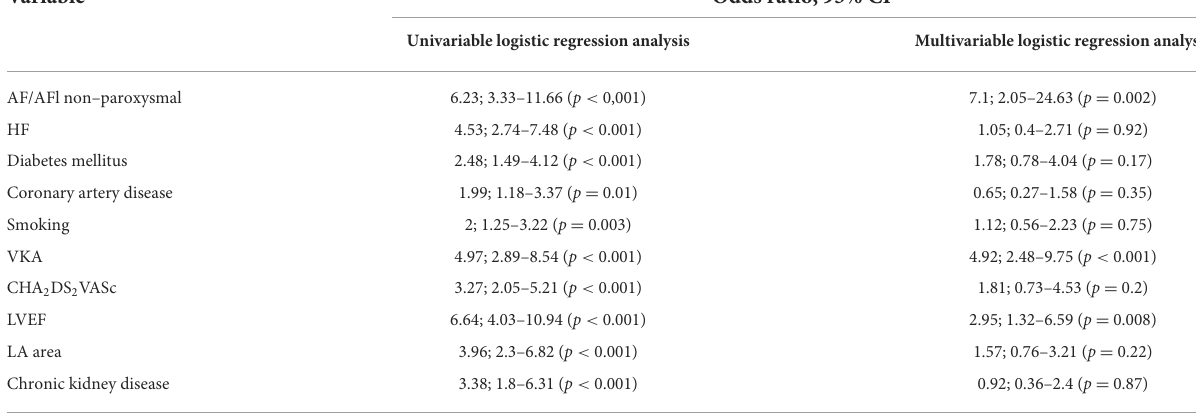
TABLE 3 Results of univariable and multivariable logistic regression analysis – predictors of left atrial thrombus. Variable Odds ratio; 95% CI Univariablelogistic regressionanalysis Multivariable logistic